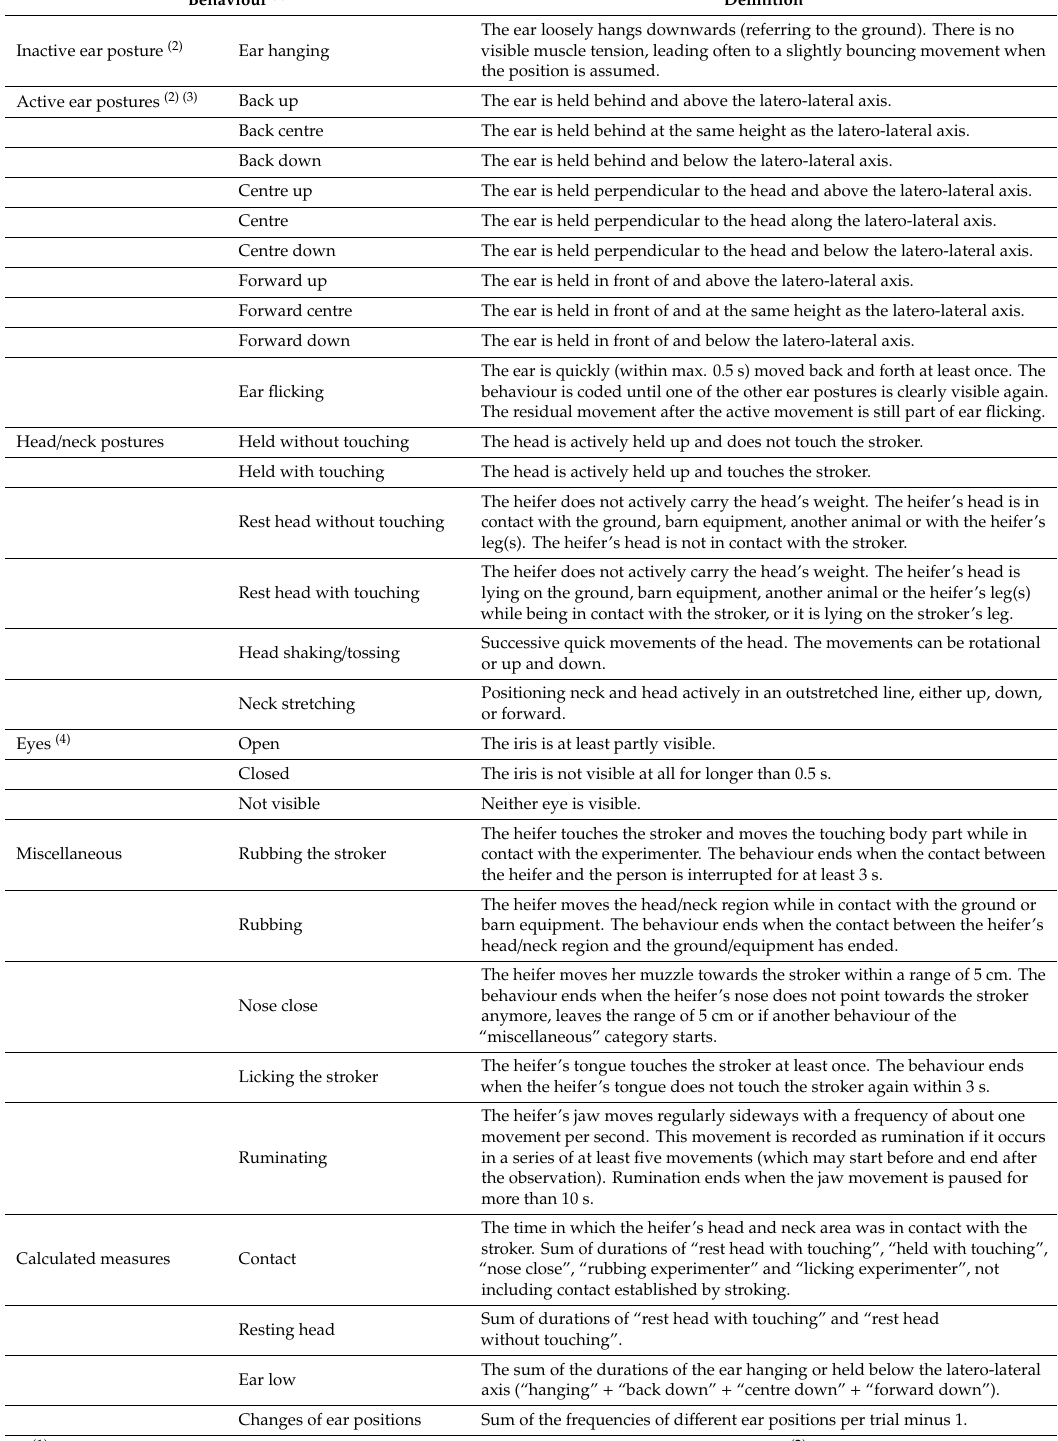
Table 1. Ethogram adapted from References